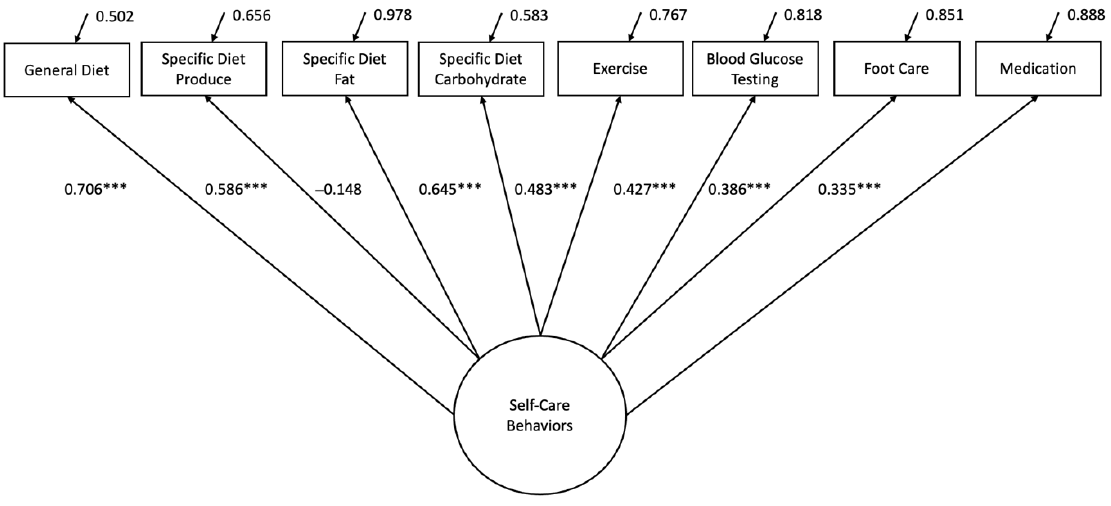
Figure 1. Confirmatory factor analysis (CFA) model. Standardized CFA solution; *** p < 0.001.